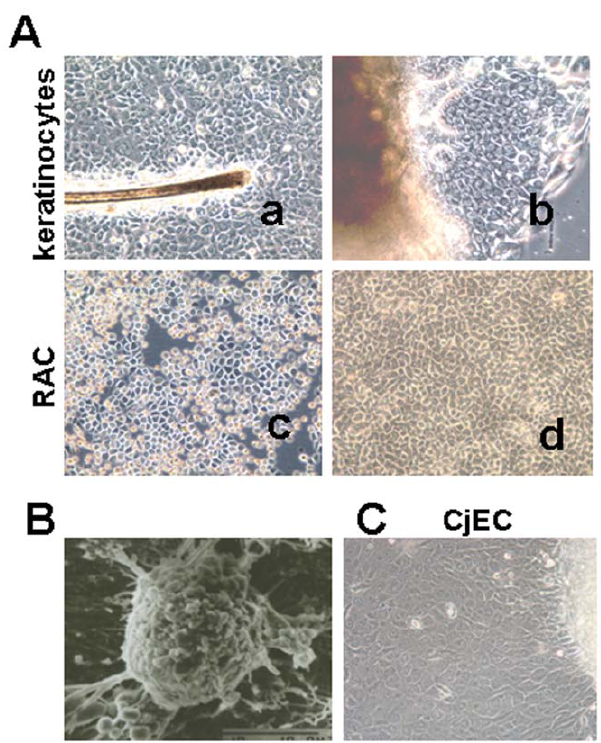
Figure 1. Growth pattern of monkey keratinocytes and Rapid Adherent Cells (RAC). A. Representative phase images of primary monkey keratinocytes (P0) and RAC. a. keratinocytes (P0) growing around hair follicle and almost reaching confluence ( 6 200); b. keratinocytes growing from explants ( 6 200); c. RAC adhered on Type IV collagen coated culture flask within 20 minutes ( 6 200); d. RAC reaching confluence ( 6 200); B. Scanning electron microscopy photog- raphy of RAC ( 6 3500); C. Representative phase image of conjunctival epithelial cells growing from explant ( 6 200).